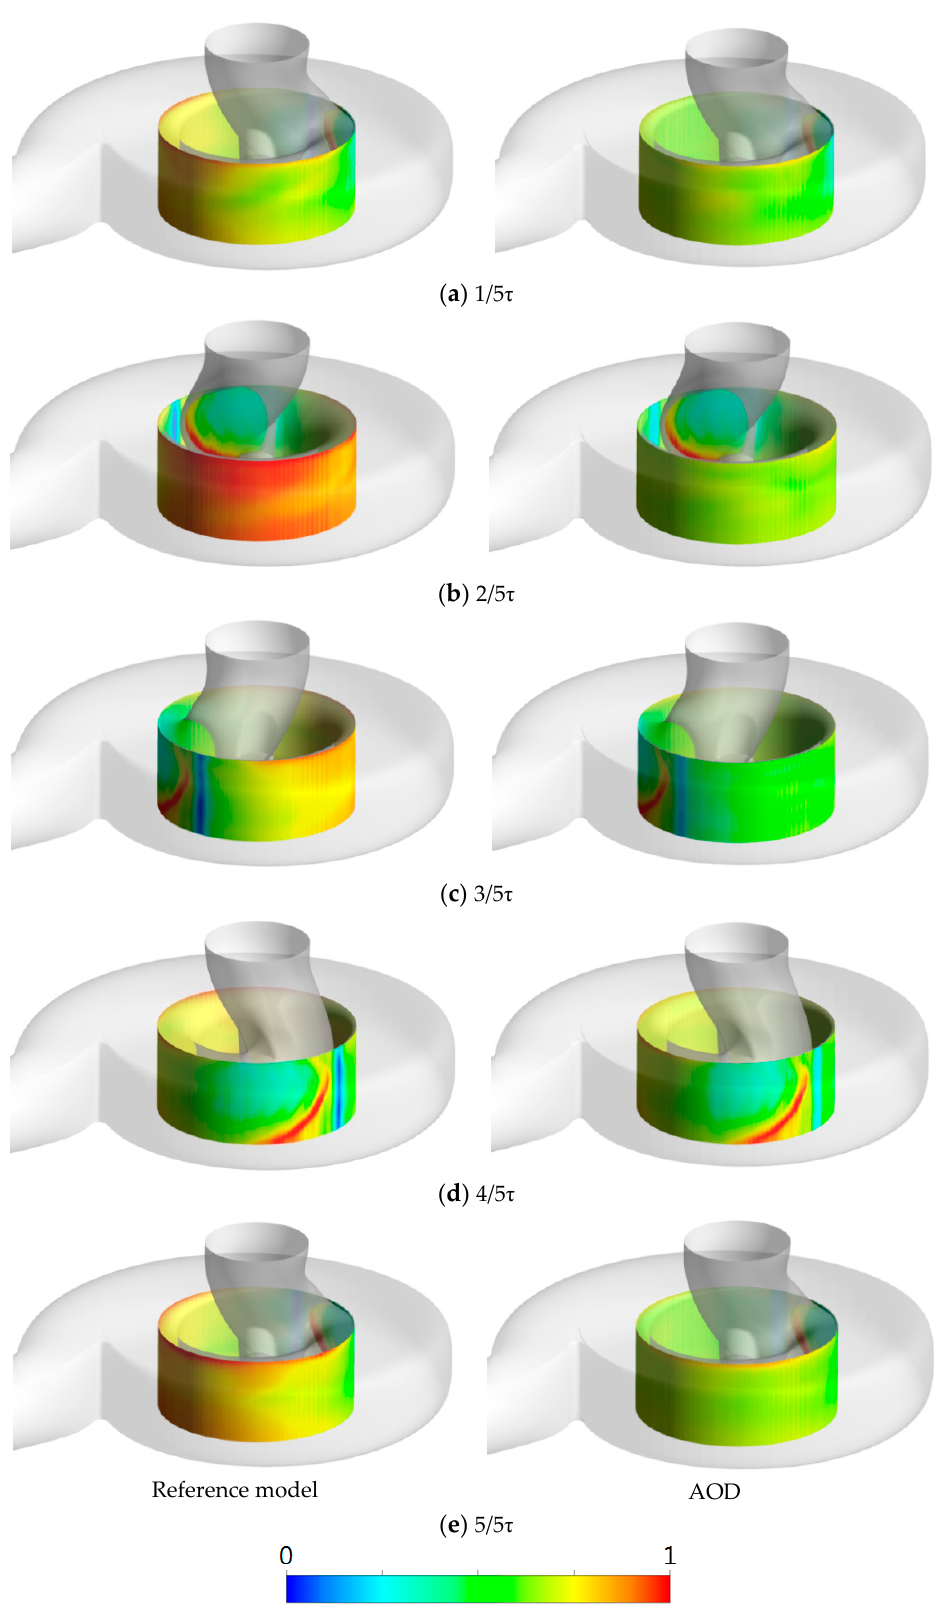
Figure 17. Instantaneously changed unsteady pressure contours during one rotation at exit surface of impeller.